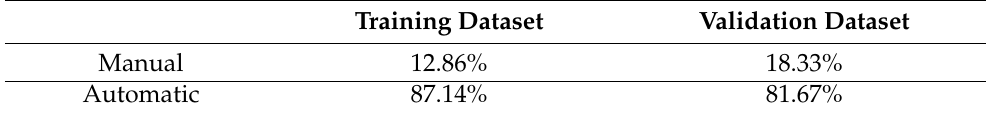
Table 3. Comparison in percentage of segmentation (manual or automatic) scans chosen to be refined in the second stage of ground truth data generation. The segmentations chosen to be refined were closer to the target ground truth, therefore requiring fewer corrections to be